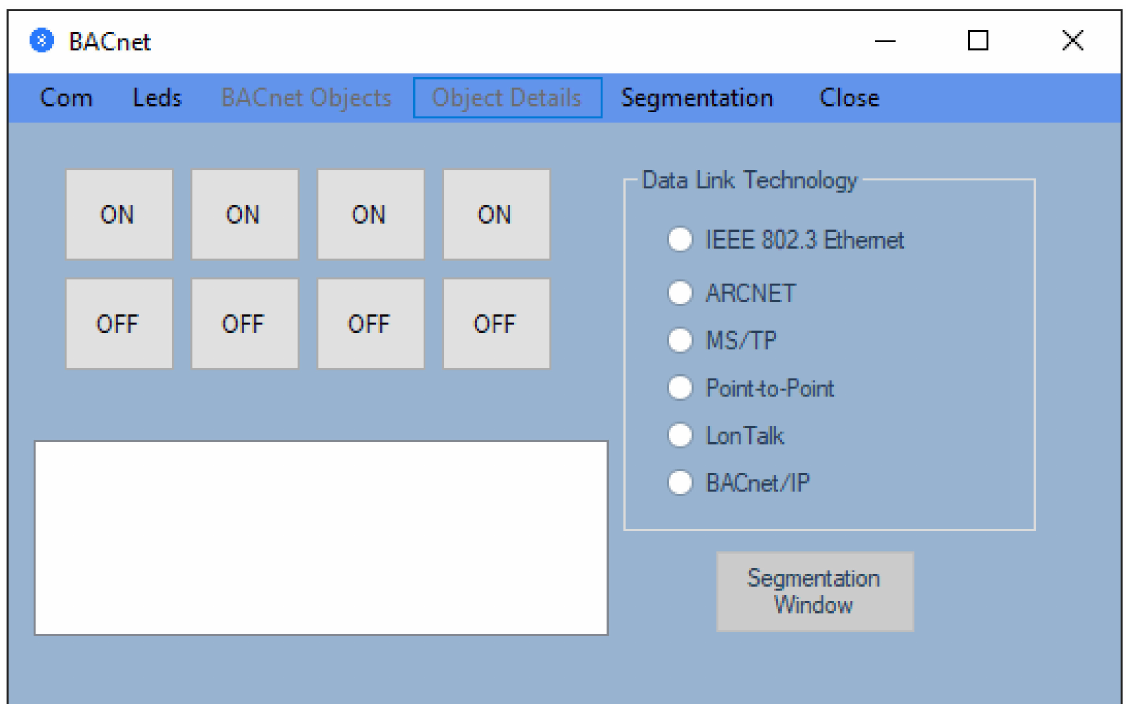
Figure 4. The main window of the application executed on a